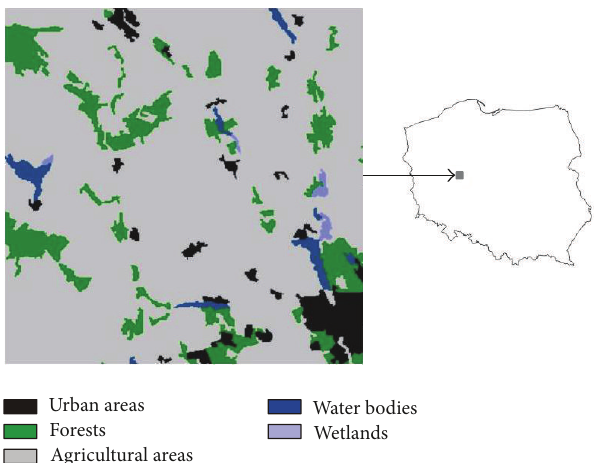
Figure 3: Land-use units near the city of Poznan based on the Corine Land Cover 2000.